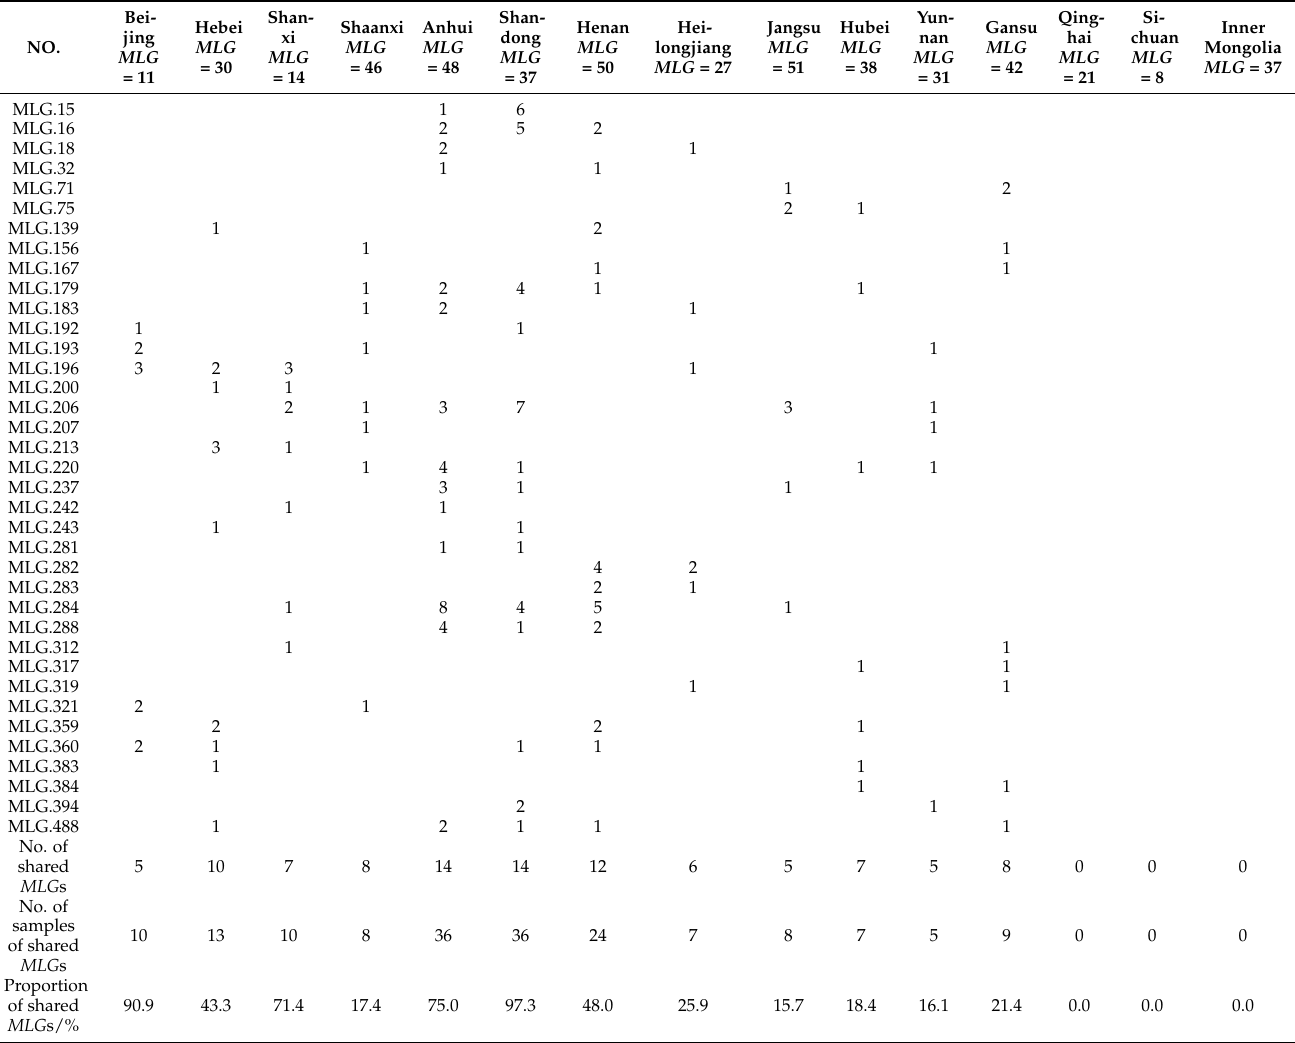
Table A3. The shared genotype and numbers of different Pt